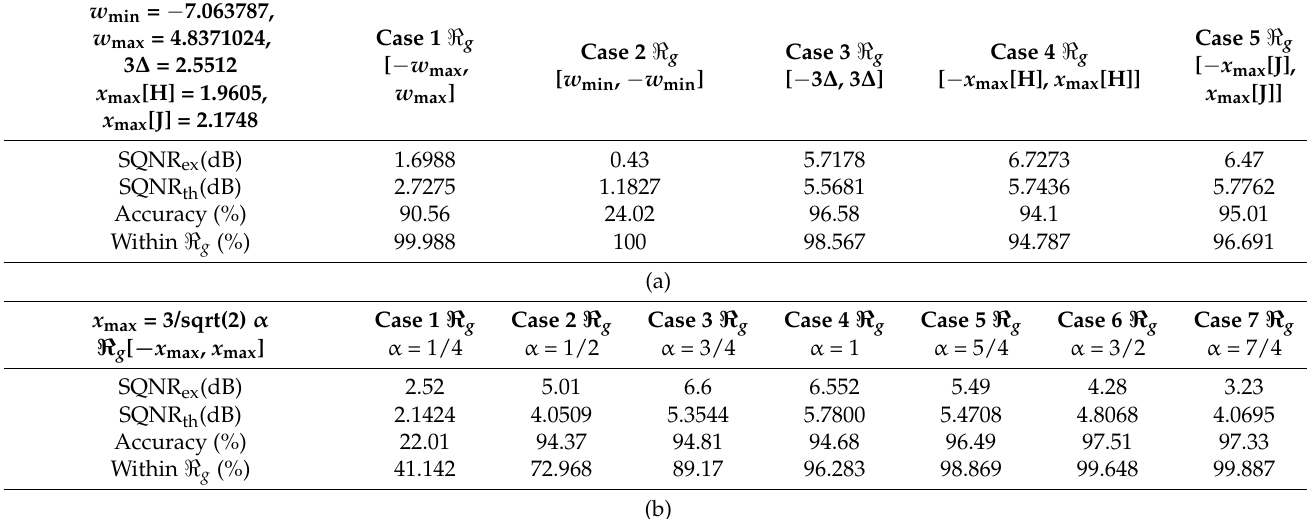
Table 6. SQNR and QNN model’s accuracy for MLP trained on MNIST dataset: (a) the application of